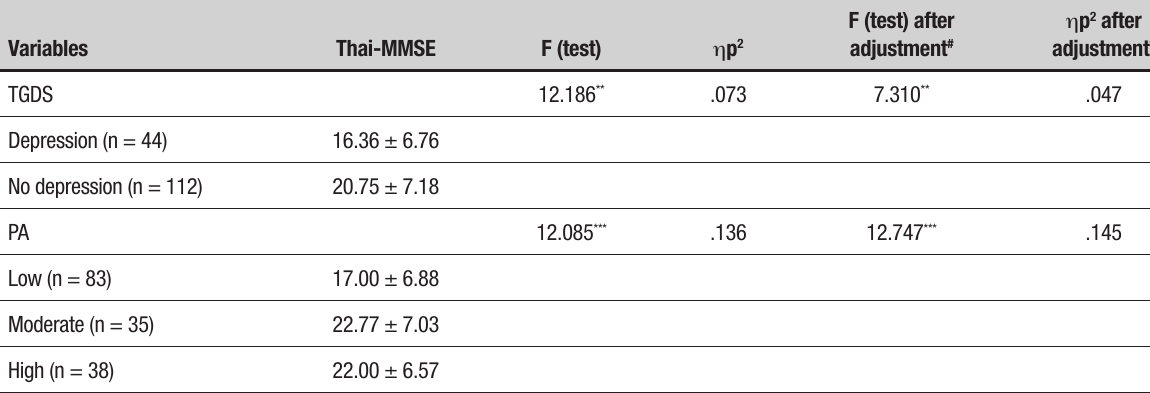
Table 2. Thai-MMSE scores according to depression and physical activity. Variables